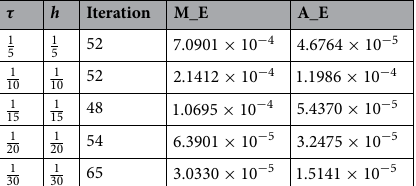
Table 3. Numerical results for the Example 2, where γ = 0.1 .